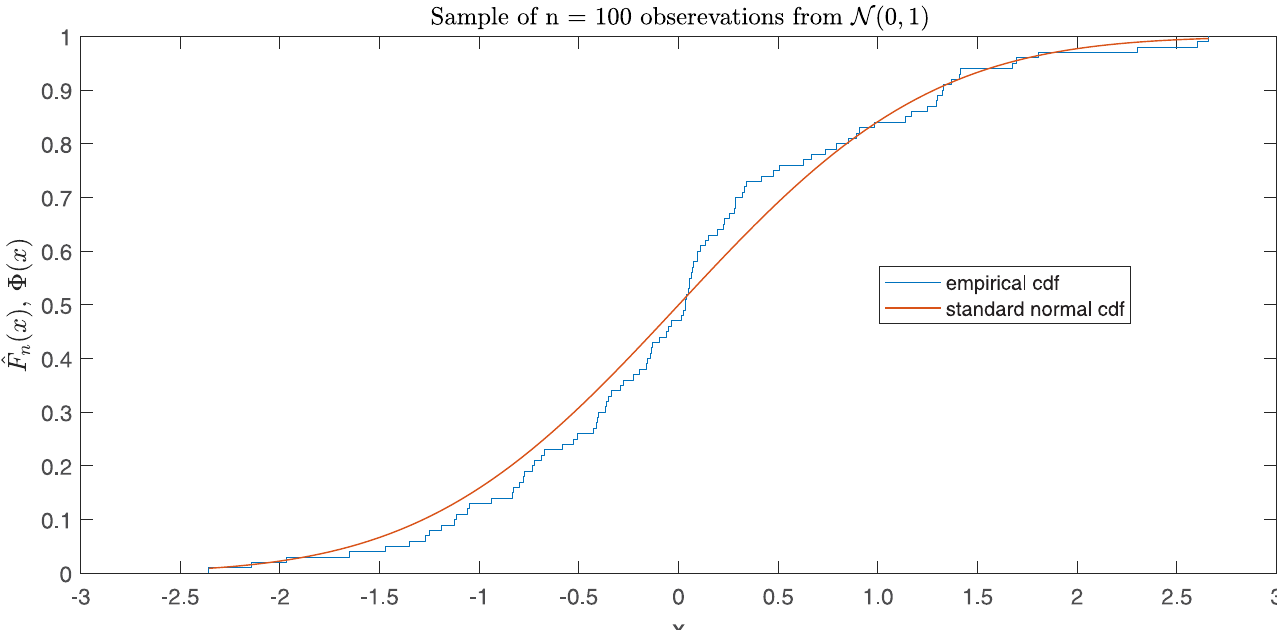
Fig 2. Plot of the empirical cdf computed from the dataset S1 Dataset appended as supporting information, and the standard normal cdf F as the model to be established.